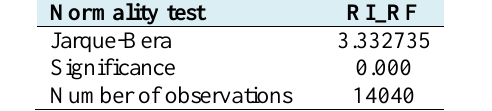
Table 3. Jarque-Bera statistic for research dependent variable after